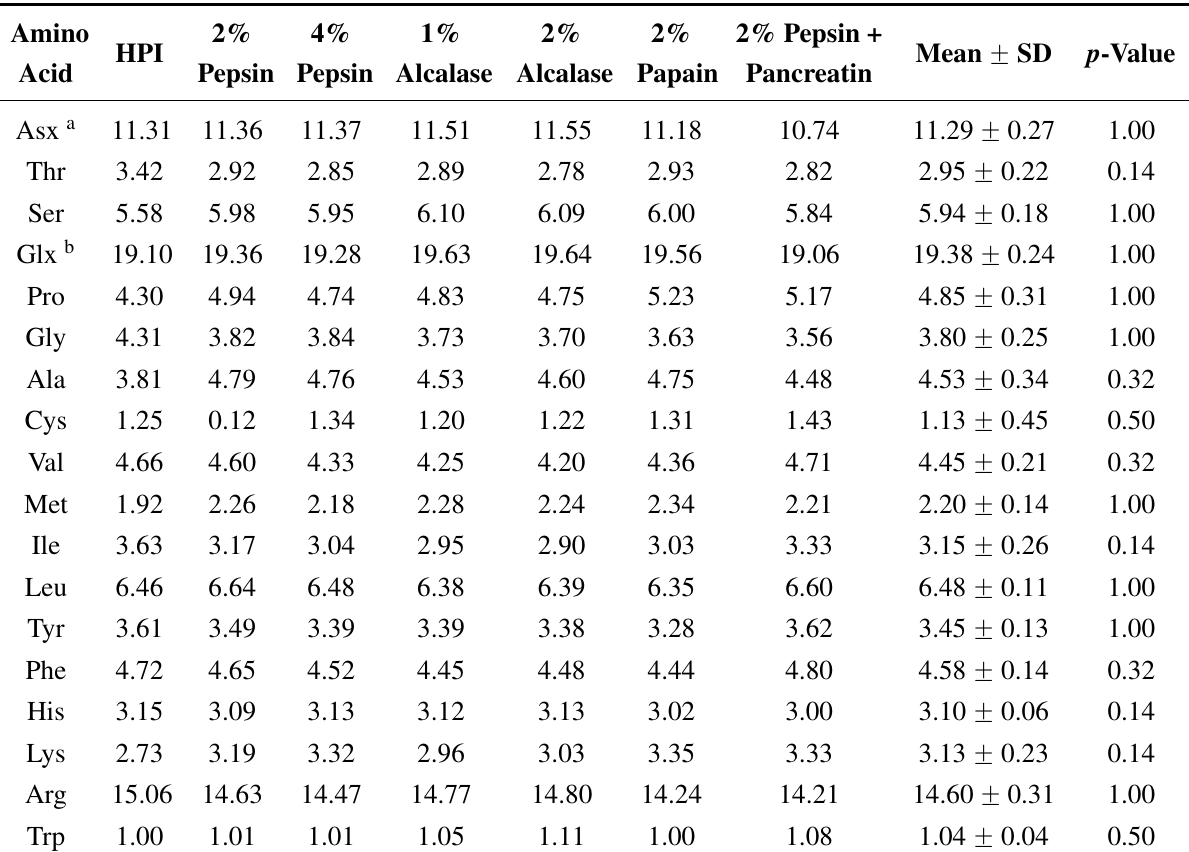
Percentage amino acid composition of hemp seed protein isolate (HPI) and enzymatic protein hydrolysates.